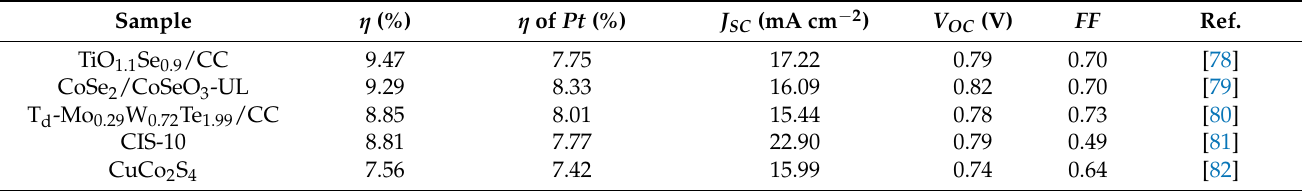
Table 5. The photovoltaic parameters of various metal compound electrocatalysts in the DSSC with an I − /I 3 − redox couple are compared under 1.0 sun (AM 1.5G, 100 mW cm − 2 ).